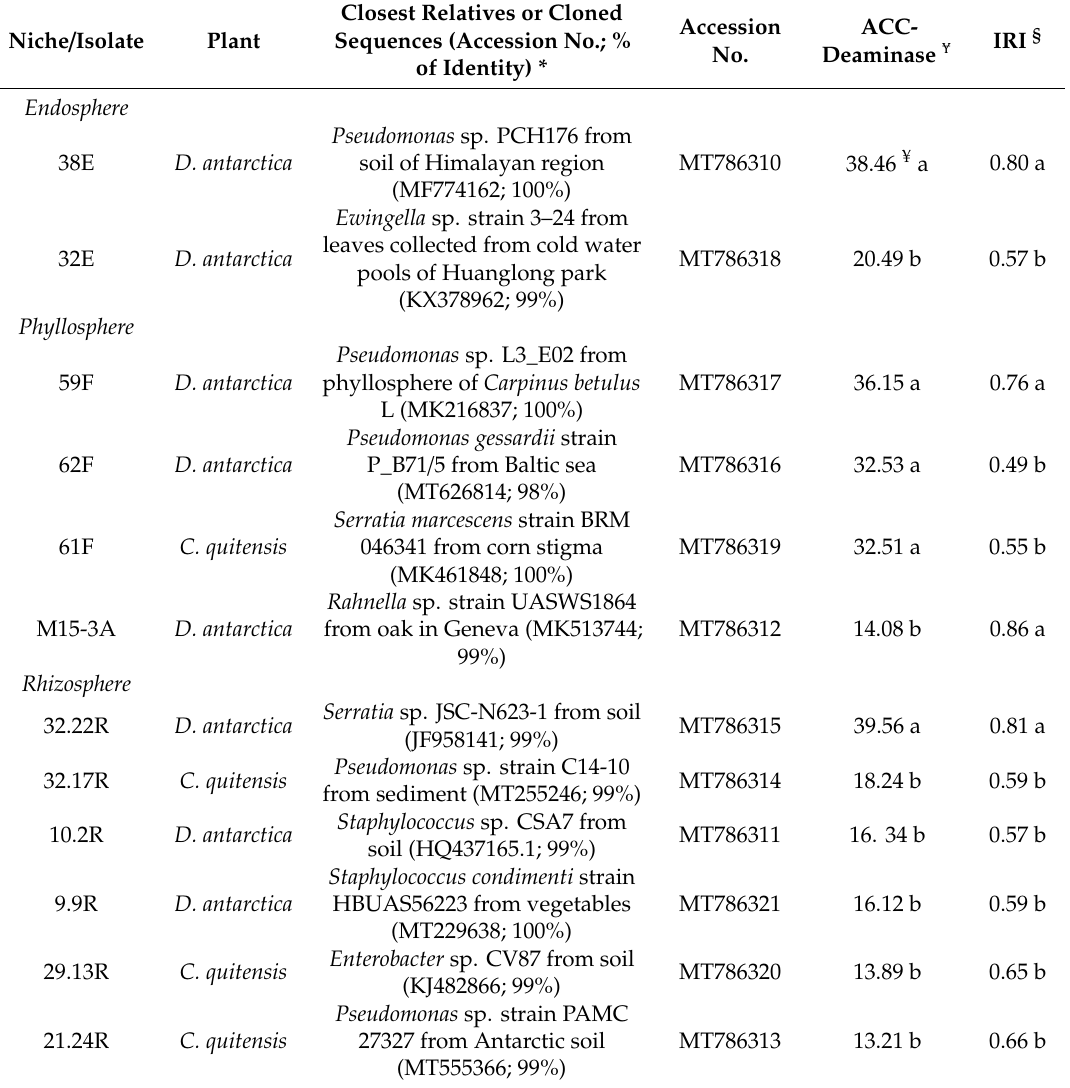
Table 2. Characterization of selected cold-tolerant hyper-ACC-degrading bacteria isolated from Antarctic vascular plants ( Deschampsia antarctica and Colobanthus quitensis ) by partial sequencing the 16S rRNA gene.